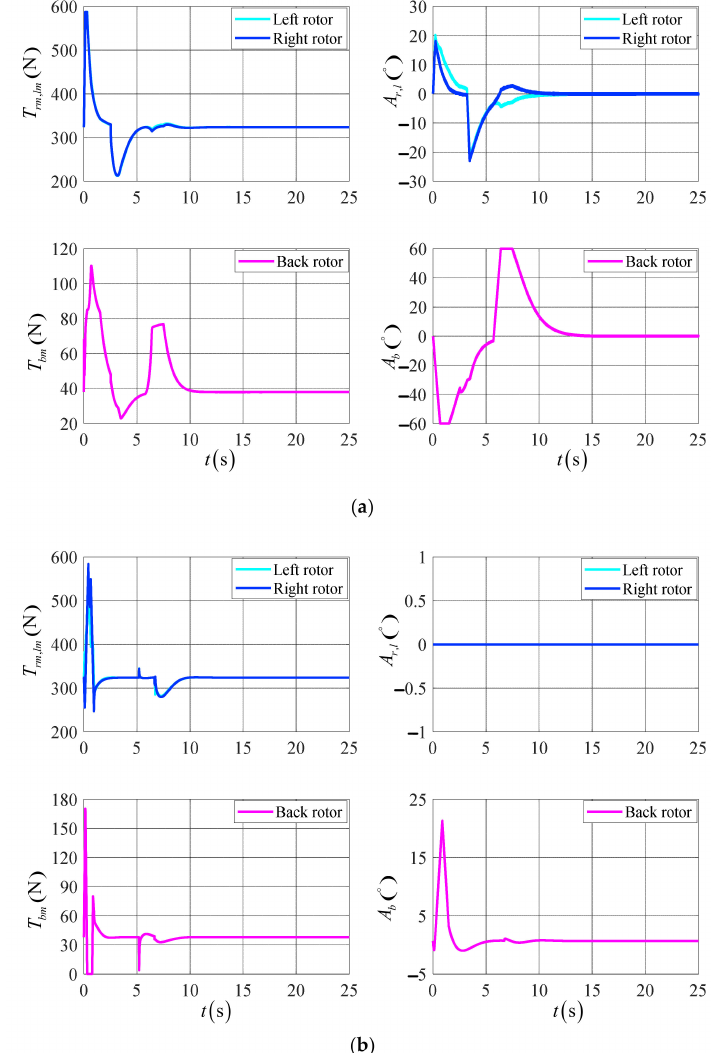
Figure 10. The variation of the UAV actuators’ control in the target point flight. ( a ) The results of the DTVC scheme; ( b ) the results of the conventional control